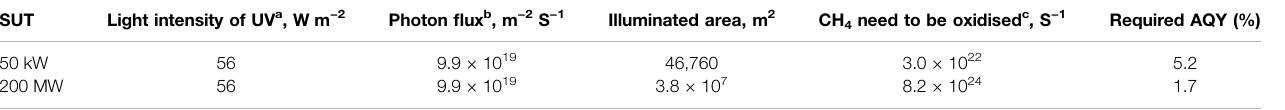
TABLE 7 | Estimation of AQY required in a SUT for total removal of atmospheric CH 4 . SUT Light intensity of UV a , W m −